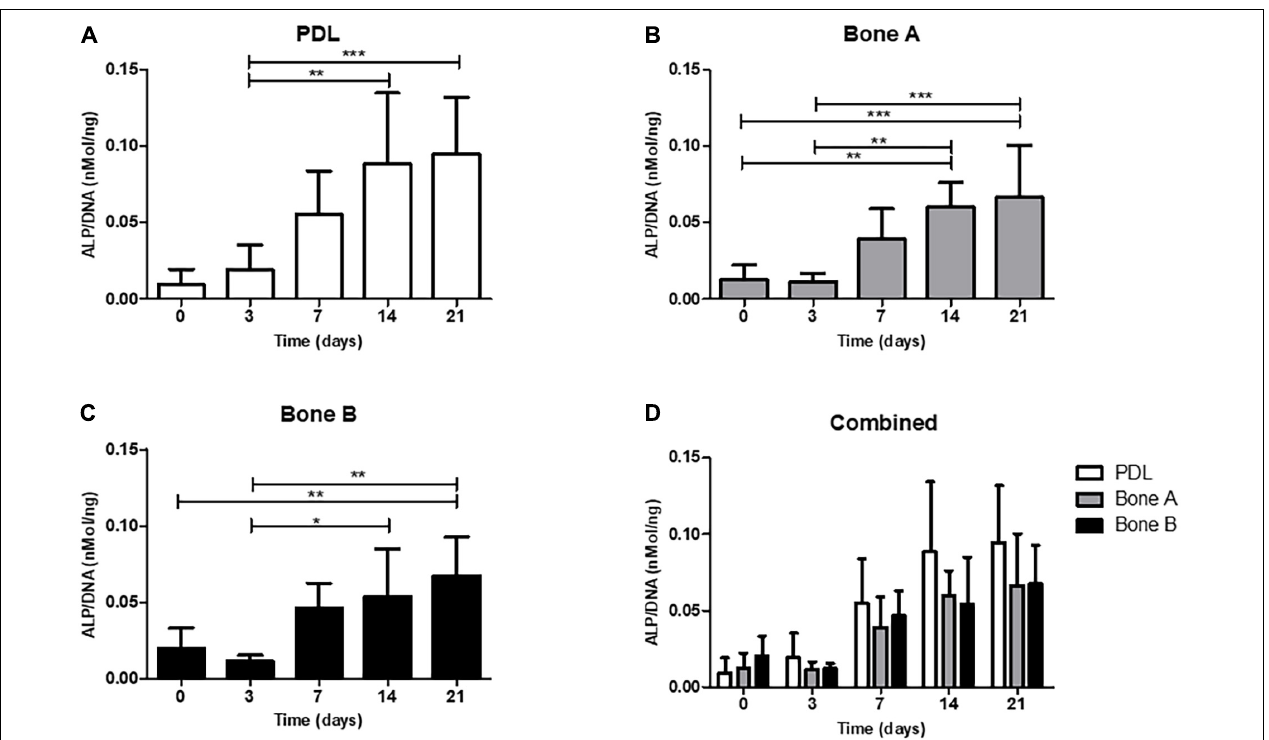
FIGURE 4 | Alkaline phosphatase activity of (A) PDL, (B) bone A, (C) bone B, and (D) the three cell cultures combined. Alkaline phosphatase activity was assessed at day 0, 3, 7, 14, 21. Significant differences between time points are shown in panels (A–C) . No significant differences were found between PDL, bone A and b one B at each time point. Alkaline phosphatase activity is measured per cell, corrected for DNA. Means ± SD are shown ( n = 5). * p < 0.05; ** p < 0.01; *** p < 0.001 (Friedman test with Dunn’s multiple comparison post hoc test).